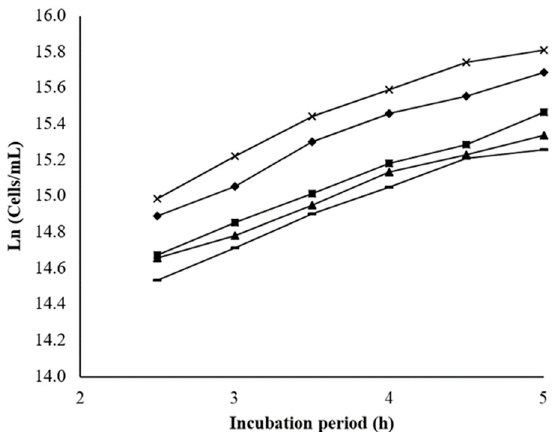
Figure 1. Growth curves of Saccharomyces cerevisiae cultures exposed to BSA NPs ( x - negative control; (cid:7) - 3.0 µ M; (cid:4) - 3.9 µ M; — - 4.6 µ M; (cid:78) - 5.3 µ M). Yeast growth is presented as the natural logarithm of cell concentration, which is expressed as number of yeast cells / mL. The interval 2–5 h was considered as the log growth phase (n = 4, mean ±